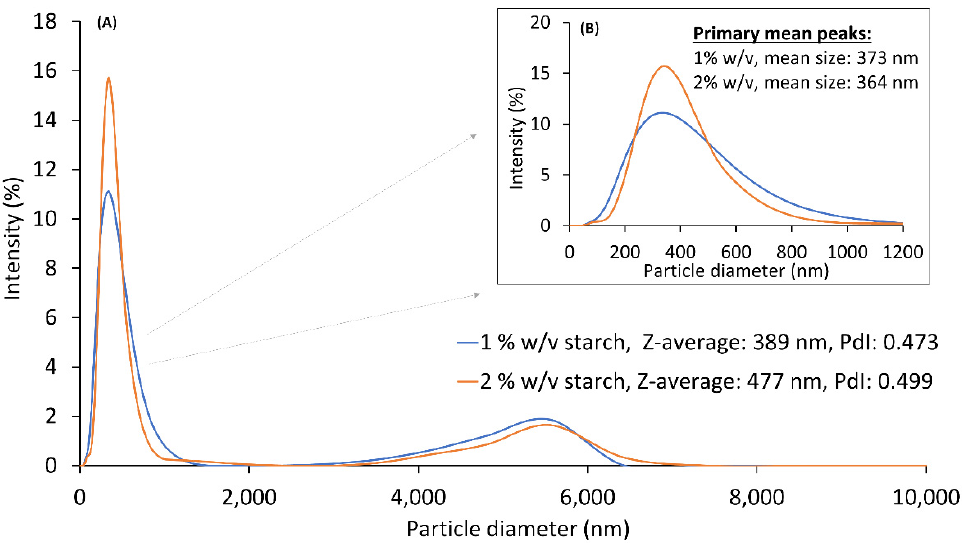
Figure 9. Particle size distribution (PSD) for the effect of starch concentration in the semi-batch reactor (SBR) set-up at 800 rpm agitation and 1 mL/s ethanol addition. ( A ) Z-average and polydispersity index (PdI) values calculated for combined primary and agglomerated peaks. ( B ) Focused image of primary peaks for 1% w / v and 2% w / v starch.